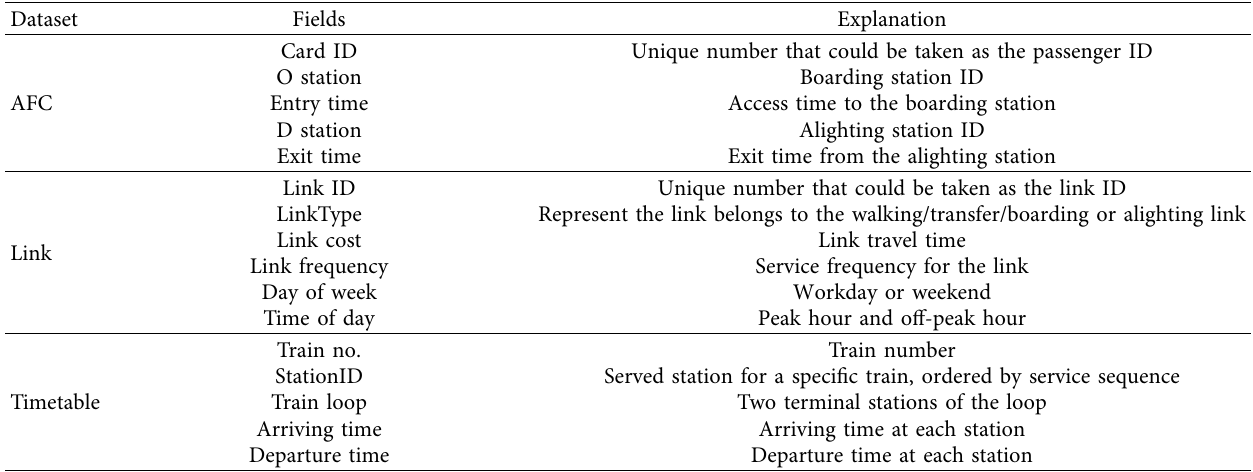
Table 2: Dataset in the empirical